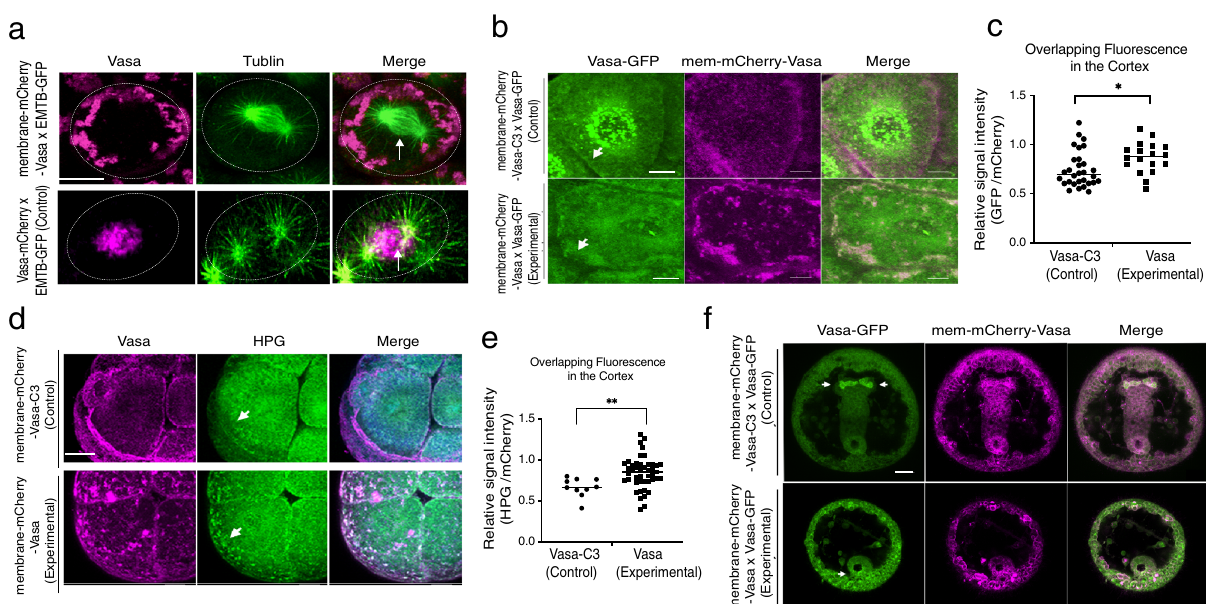
Fig. 6 Vasa nucleates ectopic translation on the membrane. a membrane-mCherry-Vasa (magenta, upper panels) was recruited to the membrane (outlined by a white circle) and away from the spindle (arrow) ( n = 10), while Vasa-mCherry (magenta; control; lower panels) was enriched speci fi cally on the spindle ( n = 10). EMTB-3xGFP (green) was used as a microtubule marker. b Vasa-GFP (green) mRNA was coinjected with membrane-mCherry-Vasa or Vasa-C3 (red) mRNA. The overlapping signal of GFP and mCherry is shown in orange. membrane-mCherry-Vasa, n = 33; membrane-mCherry-Vasa-C3 ( n = 29). c The graph represents the overlapping mean fl uorescence on the cortex (green/ magenta) of controls versus experimental conditions. Average values from 3 detection ROIs per embryo were obtained for each group, n = 30 for membrane-mCherry-Vasa-C3 (a total of 90 ROIs) and n = 18 for membrane-mCherry-Vasa (a total of 54 ROIs). Adjusted p -value, 0.022. d New protein synthesis (HPG signal, green) was detected on the plasma membrane with membrane-mCherry-Vasa (arrows, n = 18), but little with membrane-mCherry-Vasa-C3 ( n = 30) in 16-cell stage embryos. A whole Z-section of the cell of interest (1 μ m per slice; ~35 slices in total) presented as a maximum 2D projection. e The graph represents the overlapping mean fl uorescence on the cortex (green/ magenta) of the control versus experimental condition. Average values from 3 detection ROIs per embryo were obtained for each group, n = 10 for membrane-mCherry-Vasa-C3 (a total of 30 ROIs) and n = 45 for membrane-mCherry-Vasa (a total of 135 ROIs). Adjusted p -value, 0.009. f Membrane-mCherry-Vasa injected embryos failed in gastrulation as well as Vasa localization in the germline (arrows). Membrane-mCherry (magenta), Vasa-GFP (green). A whole Z-section of the cell of interest (1 um per slice; ~35 slices in total) presented as a maximum 2D projection. All experiments were performed at least three independent times. All scale bars except for ( f ) = 10 μ m; Scale bar of ( f ) = 20 μ m. Multiple t -tests were used for all statistical analyses in this fi gure. * p < 0.05, ** p < 0.01. Columns represent means ± SD or SEM. Source data are provided as a Source Data fi